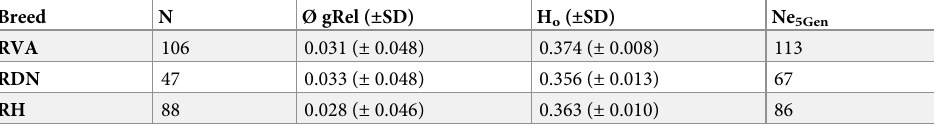
Table 2. Number of animals (N), average genomic relationship ( Ø gRel), average observed heterozygosity (H o ) and most recent effective population size (Ne 5Gen ) for Angler (RVA), Red-and-White dual-purpose (RDN) and Red Holstein